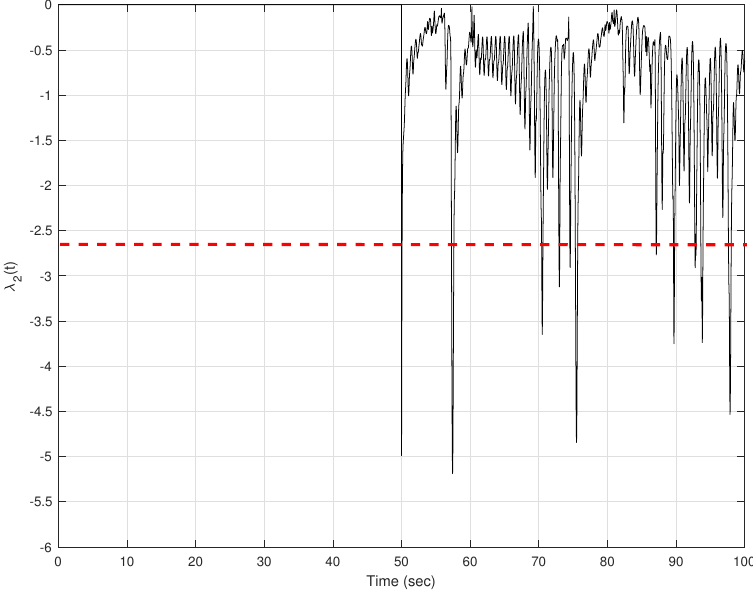
Figure 9. Time evolution of the eigenvalue λ 2 ( t ) , dashed line divides the exponential stability region for λ 2 ( t ) greater than d and stability for λ 2 ( t ) lees than d